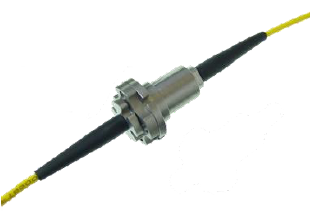
Figure 7. Picture of the optical rotary coupler.